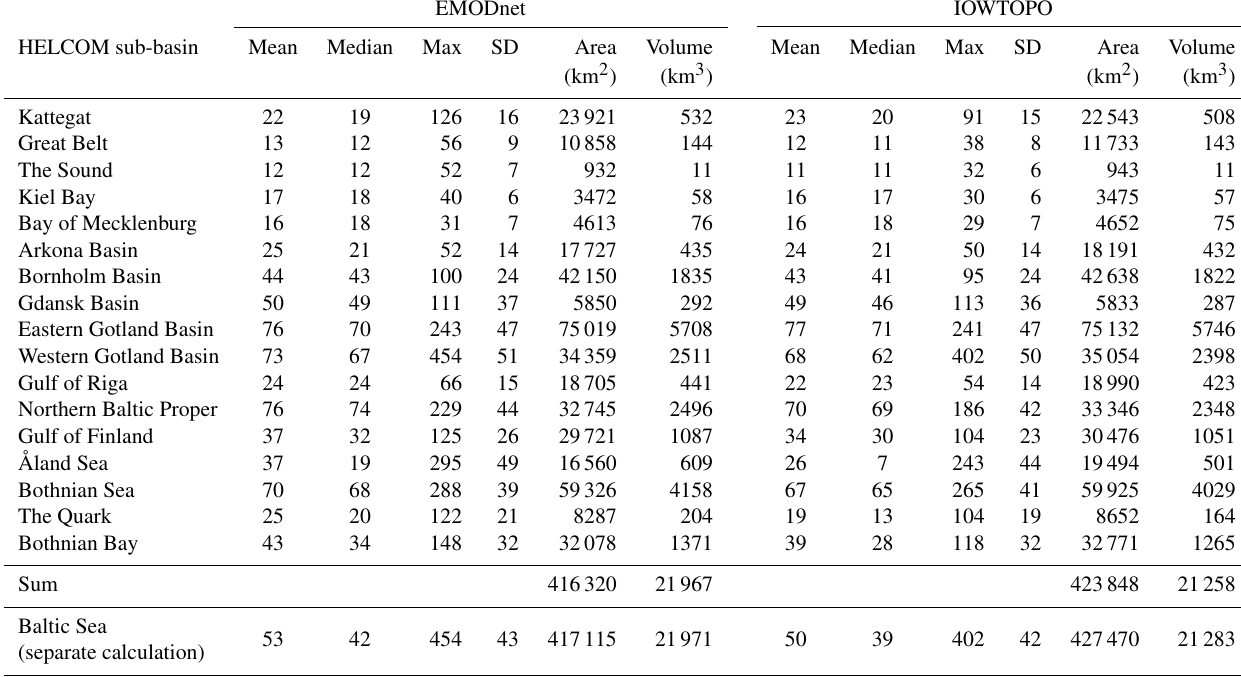
Table 1. Descriptive statistics of the EMODnet and IOWTOPO DBMs calculated using the depths of the grid cells in respective DBMs. Note that the grid cells themselves give the mean of soundings within that cell. For example, the maximum depth in the Western Gotland Basin corresponds to the Landsort Deep, commonly cited as 459m, yet the corresponding cell in EMODnet gives 454m and in IOWTOPO is even shallower (402m), because the coarser resolution implies that grid cells contain mean depths derived from larger